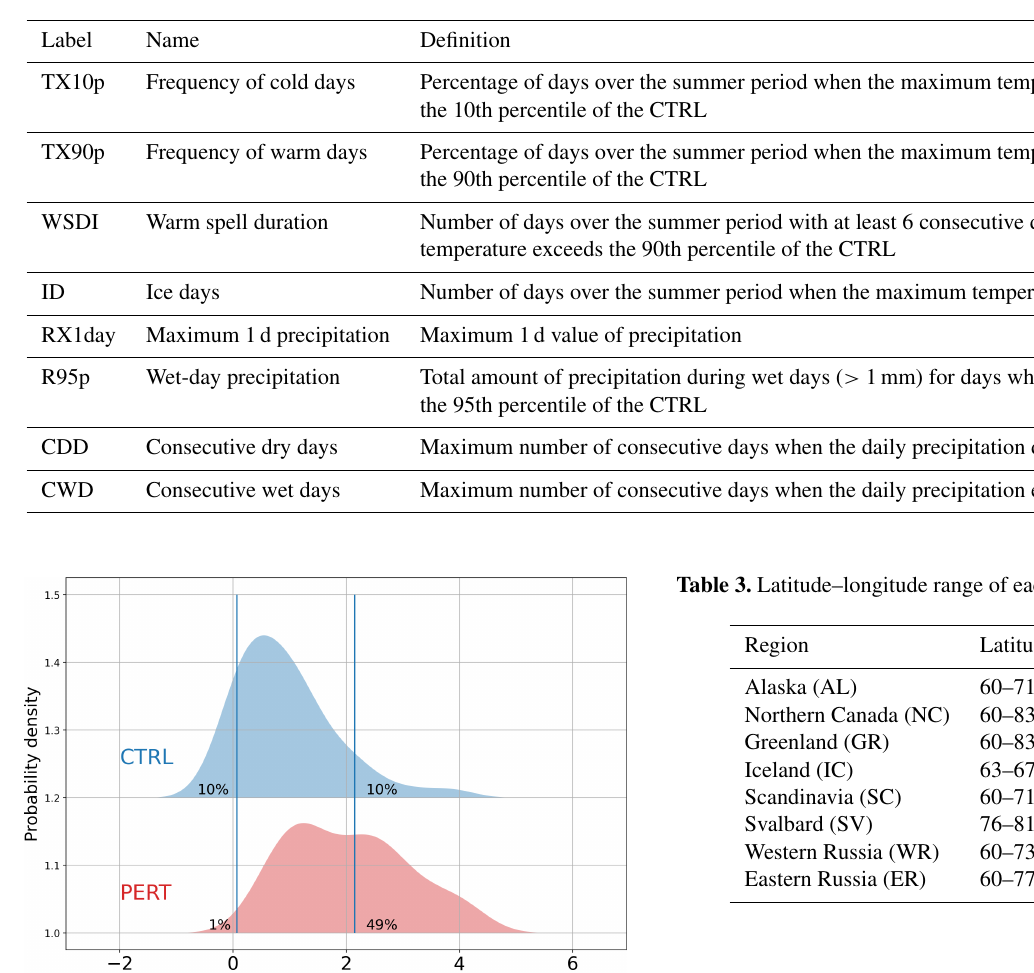
Table 2. The eight climate extreme indices used in this study.